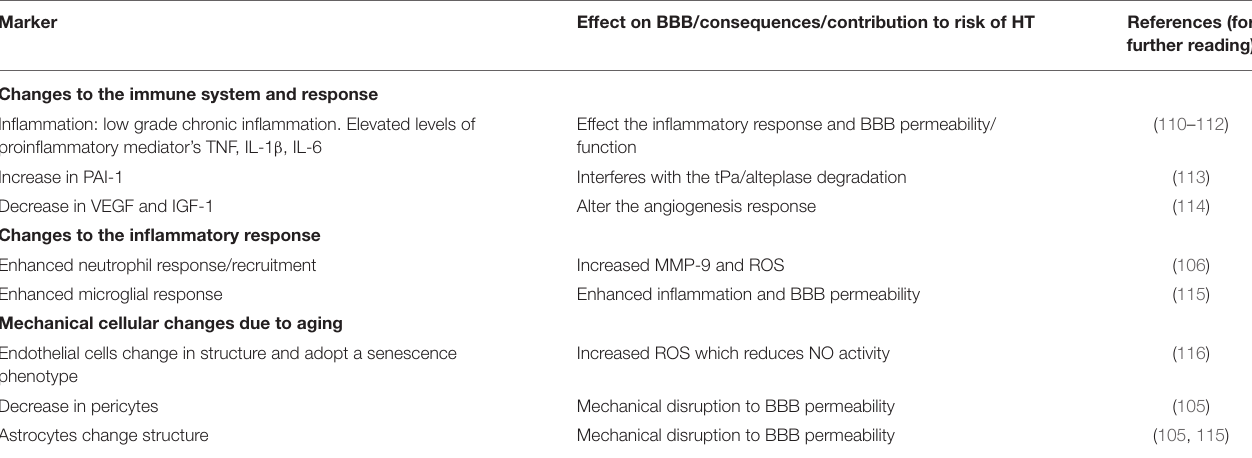
TABLE 7 | Summary of factors related to age that impact HT and BBB.